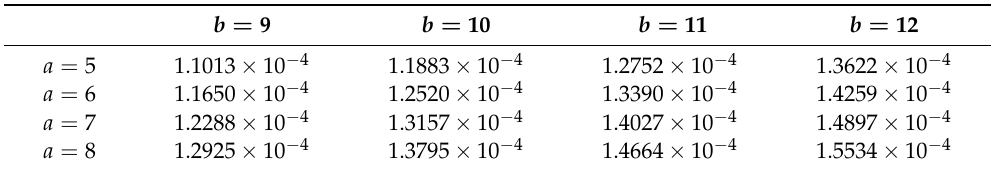
Table 3. The maximum absolute error of the analytic and numerical solutions with different parame- ters a and b .